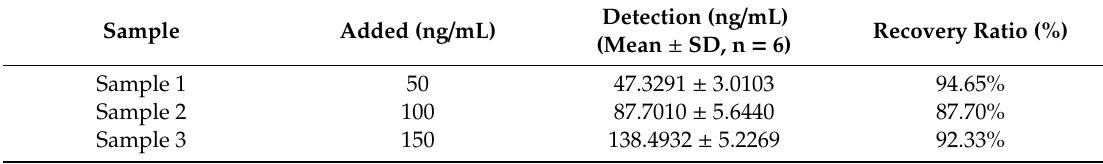
Table 1. The recovery results for staphylococcal enterotoxin A (SEA) detection in milk.